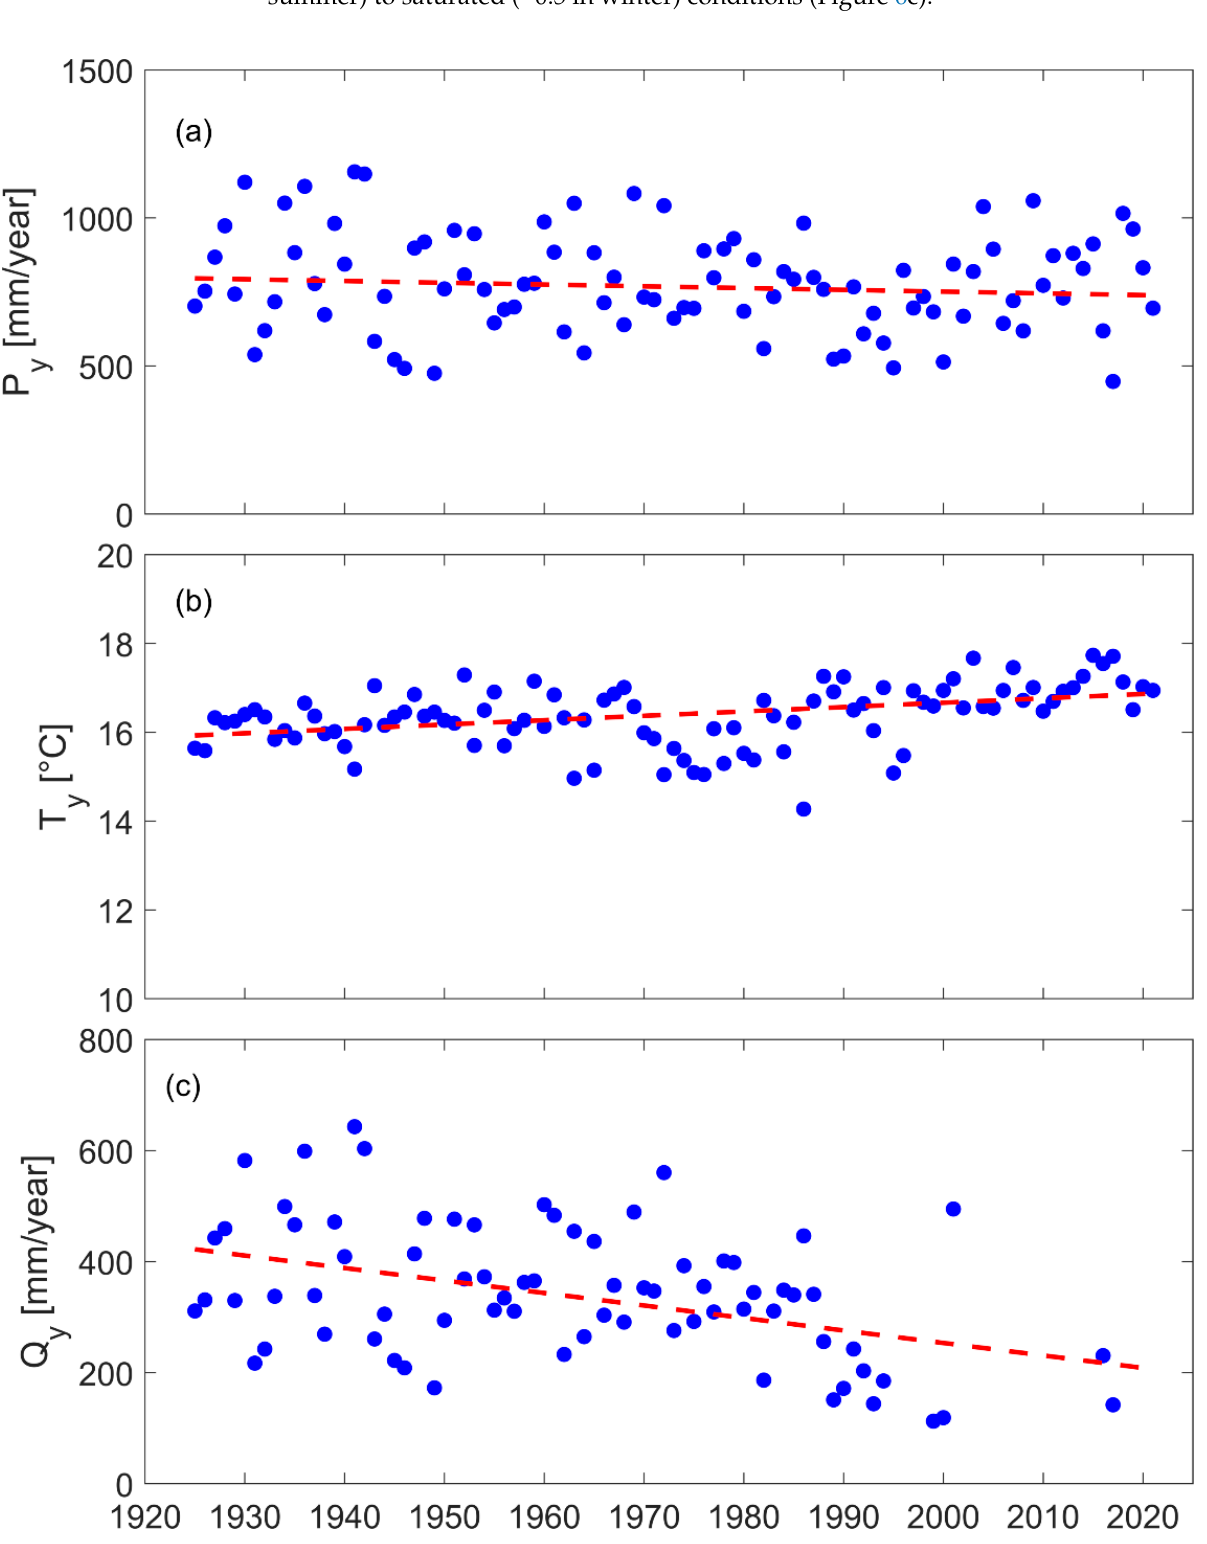
Figure 4. For the Fluminimaggiore basin, historical annual time series of: ( a ) precipitation (P y ), ( b ) air temperature (T y ), and ( c ) runoff (Q y ). The slopes of the trend lines (red dashed) are estimated using the Theil − Sen method.